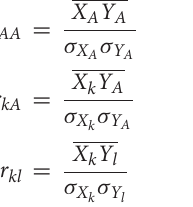
FIGURE 5 | (A) Ensemble mean linear trend α A and (B) the local ratio σ 2 α of the trend variance to the total variance.